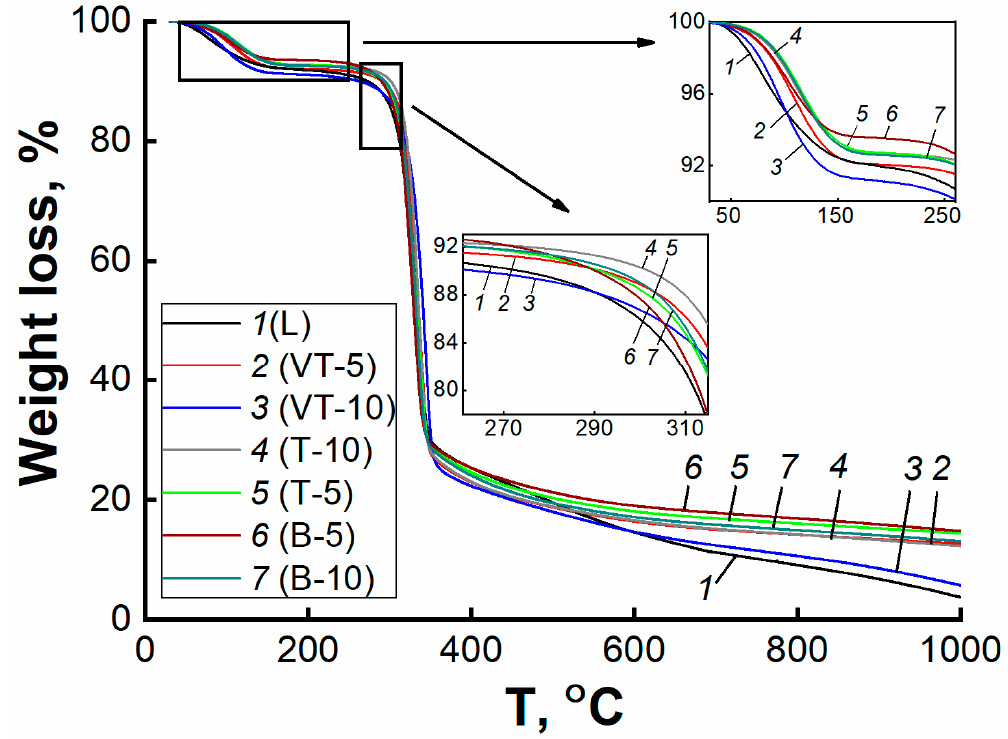
Figure 4. Thermogravimetry Analysis (TGA) curves of cellulose and composite fibers: complete curves and parts of the curves in the temperature ranges 30–260 °C and 260–315 °C. Atmosphere: argon 10 cm 3 /min. Linear heating at a rate of 10 °C/min.